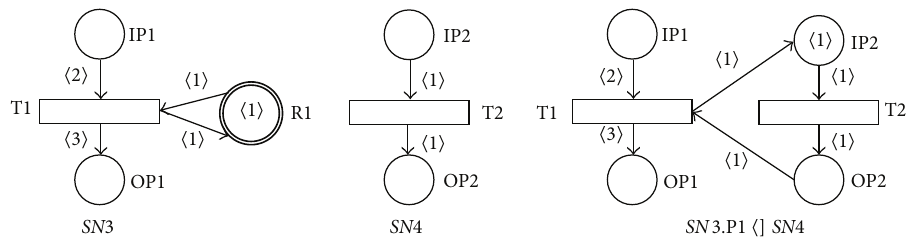
Figure 7: Result of place-substitution operation 𝑆𝑁3. R1 ⟨] 𝑆𝑁4